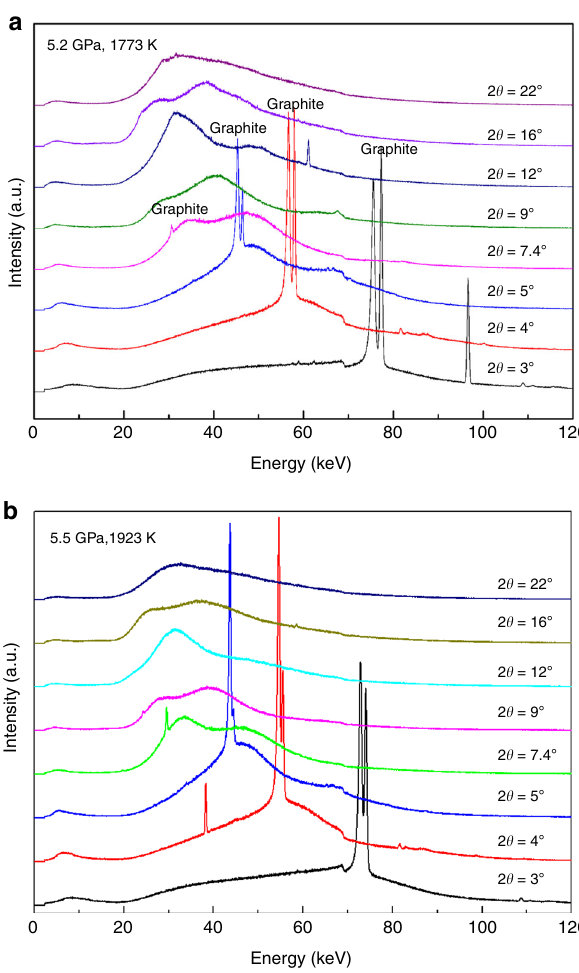
Fig. 6 Structure information obtained from multi-angle energy-dispersive X-ray diffraction measurements on amorphous CaCO 3 at 1573 and 1773 K and liquid CaCO 3 at 1873 and 1923 K. a Derived structure factor S(Q) of amorphous CaCO 3 is compared with that of liquid CaCO 3 . b The corresponding pair distribution function G(r) of amorphous and liquid CaCO 3 shows bond length variations for C-O, C-Ca, and Ca-Ca